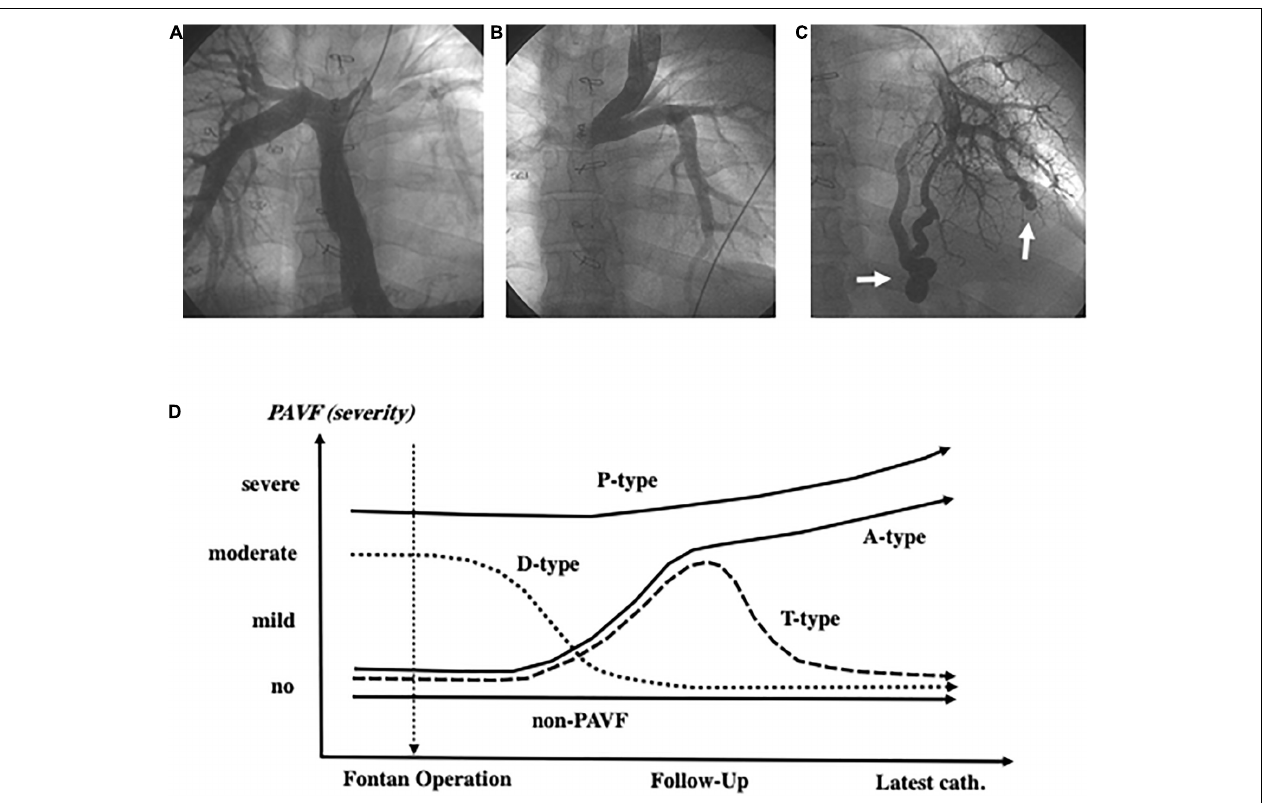
FIGURE 1 | Angiography of the inferior vena cava shows an image of the very thin left pulmonary artery (A) . The left pulmonary artery is not visible because of diminished left pulmonary blood flow due to collision of blood flow between the left superior vena cava and the inferior vena cava (B) . Arrows indicate discrete-pulmonary arteriovenous fistulae (C) . PAVF classification based on the time course after the Fontan operation (D) and the definition of each type (A, T, D, P) is described in the “Materials and Methods” section. PAVF, pulmonary arteriovenous fistulae.